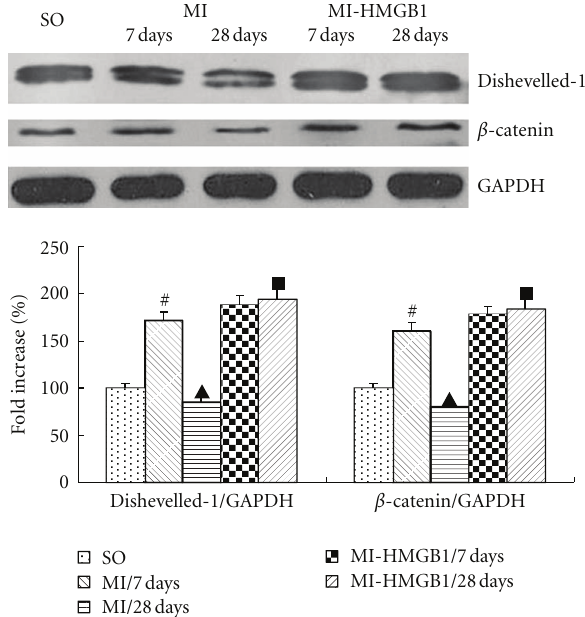
Figure 1: Expression of dishevelled-1 and β -catenin protein at di ff erent time points after MI without/with HMGB1 injection ( n = 5 for each group). # P < 0 . 05 versus SO group; (cid:2) P < 0 . 05 versus MI/7 days; (cid:3) P < 0 . 05 versus MI/28 days. SO, sham-operated control; MI, myocardial infarction; HMGB1, high-mobility group box 1 protein.